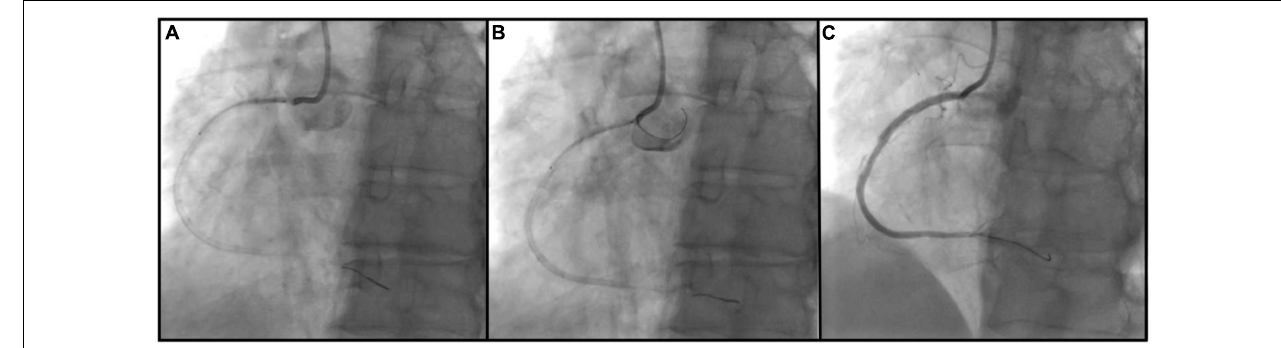
FIGURE 1 | Bumper wire technique procedural steps. (A) Ostial right coronary artery lesion is crossed with an intervention wire and coronary stent is positioned outside of the guiding catheter; (B) guiding catheter is removed from the ostium and second workhorse wire (bumper wire) is placed in the right aortic cusp with a loop. Steady forward pressure is kept on the guiding catheter which is prevented from coronary intubation by bumper wire. Proximal stent marker is placed at the tip of the guide catheter and the stent is deployed; (C) ostial coverage is confirmed in multiple angiographic views.